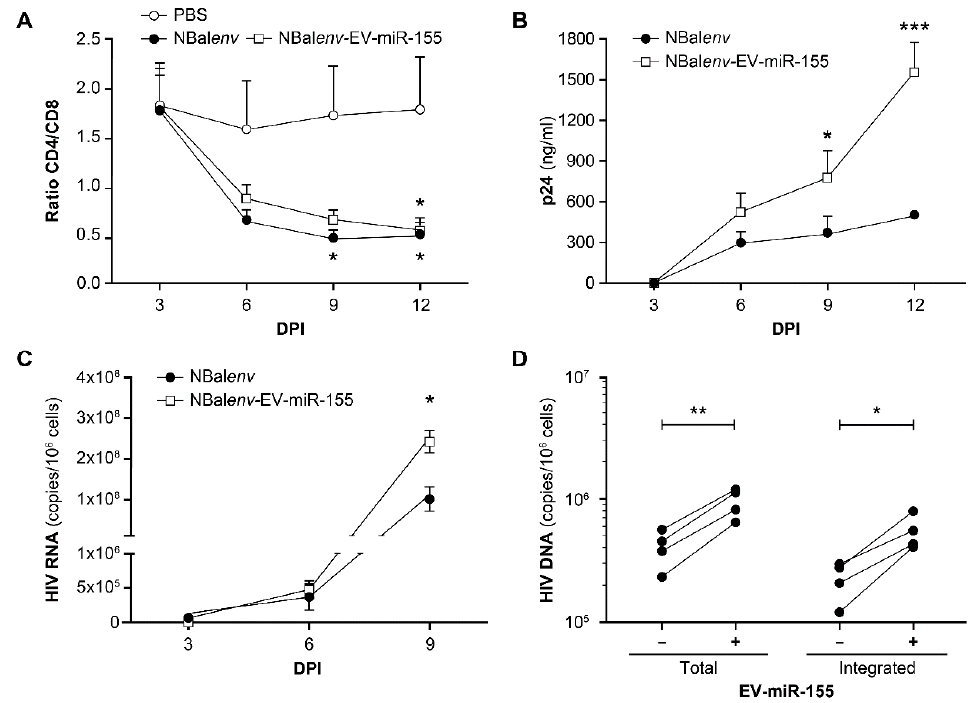
Figure 5. MiR-155 enriched EVs increase HIV-1 infection in vitro. PBMCs from different donors were pulsed with NL4.3BE or NL4.3BE/EV-miR-155, or mock-treated (with PBS) and cultured for 3, 6, 9, and 12 days. CD4+/CD8+ T cell ratio based on percentages determined by flow cytometry ( A ) Viral production based on quantitative ELISA (p24 capsid protein) ( B ) Viral load measured by RT-qPCR with a specific primer set targeting the viral LTR region ( C ) Values are averages (n = 4 independent donors). For A, B, and C, significant difference (* p < 0.05, *** p < 0.001) is based on a two-way ANOVA statistic test with the Bonferroni post-test. Total and integrated HIV DNA (based on a nested PCR assay) ( D ). The significant difference is based on a parametric paired t -test. DPI = days post-infection (* p < 0.05, ** p <